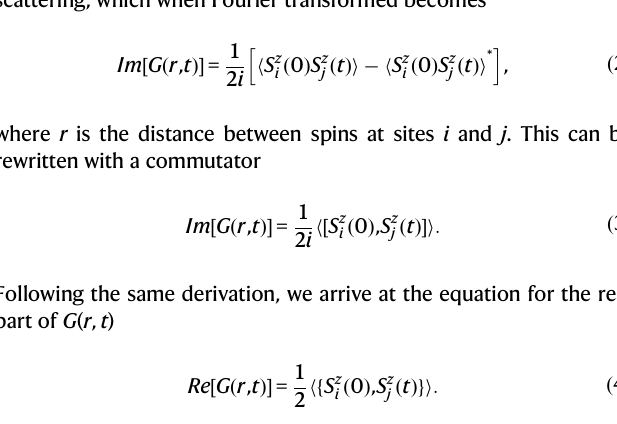
Fig.2|VanHovetime-dependentreal-spacespin-spincorrelationcomparedto theory with imaginary components. a 6K KCuF 3 scattering from the MAPS instrument, b real component of G ( r , t ), c imaginary component of G ( r , t ). Panels d – f show the same for T =0 Bethe ansatz, and g – i show the same for T =0 linear